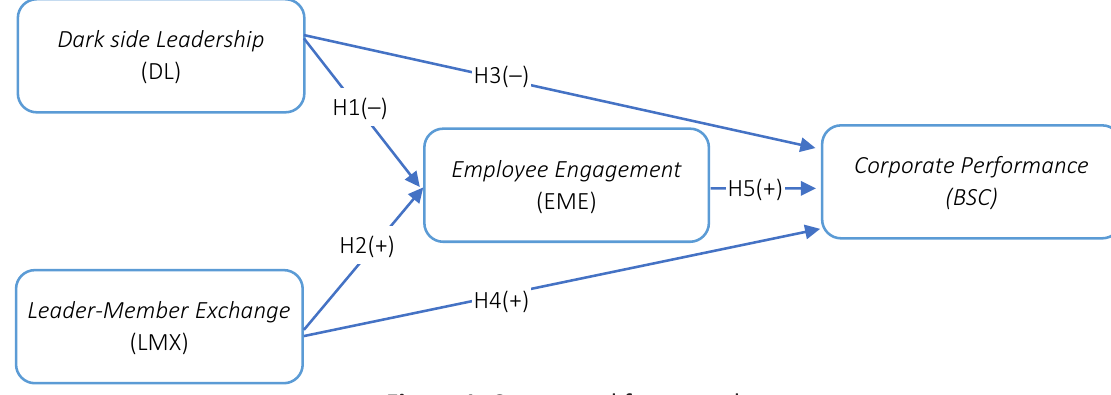
Figure 1. Conceptual